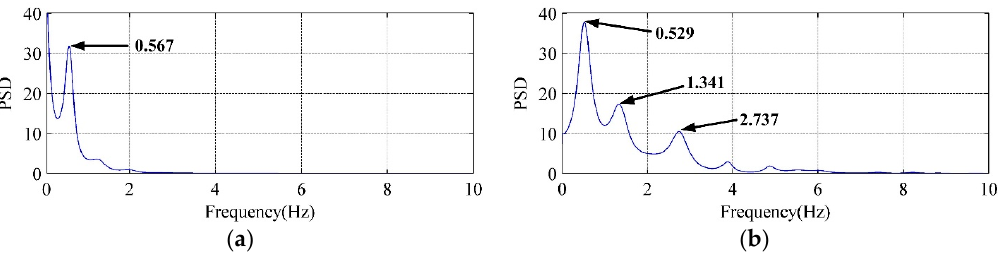
Figure 13. Comparison between vorticity monitoring data and prototype observation data of Condition 6: ( a ) Vorticity monitoring point B5; ( b ) LFN prototype observation point T9.